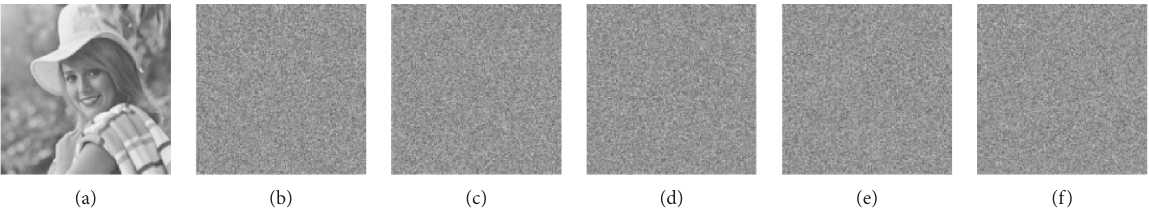
( 1 ) obtained by K R ; (c) ˇC R obtained by R ( 2 ) ˇC and ˇC R . R